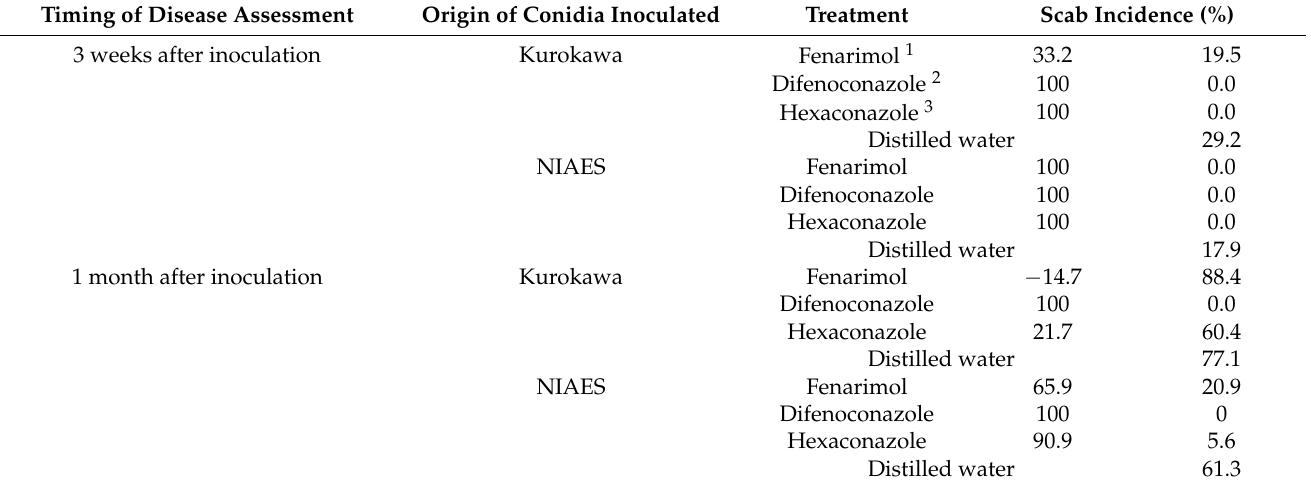
Table 4. Control efficacy of the three DMI fungicides against Venturia nashicola conidia in planta. Timing of Disease Assessment Origin of Conidia Inoculated